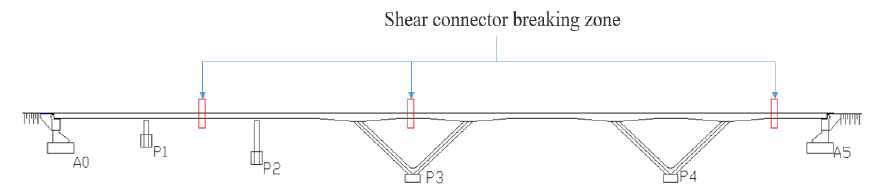
Figure 17. Schematic diagram of the damage zone of the shear resistant connector.